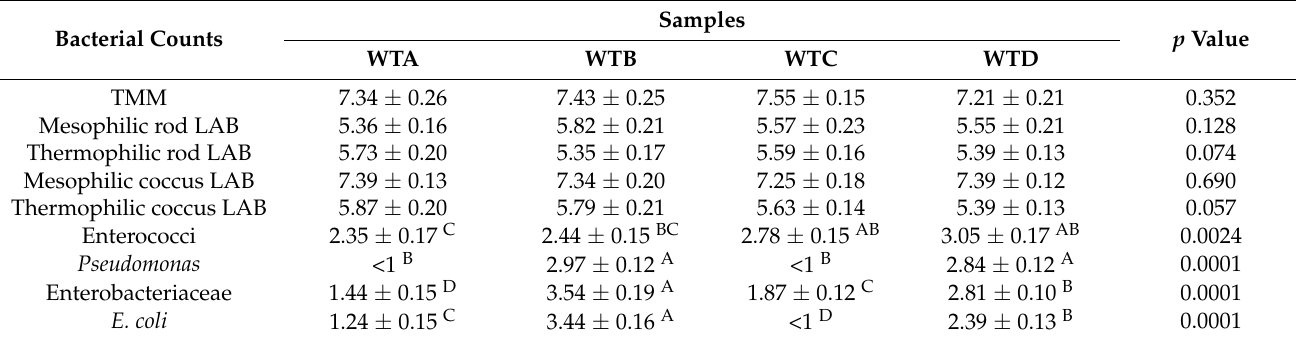
Table 2. Microbial load 1 of the biofilms of the wooden tables used for curd acidification during PDO Provola dei Nebrodi cheese